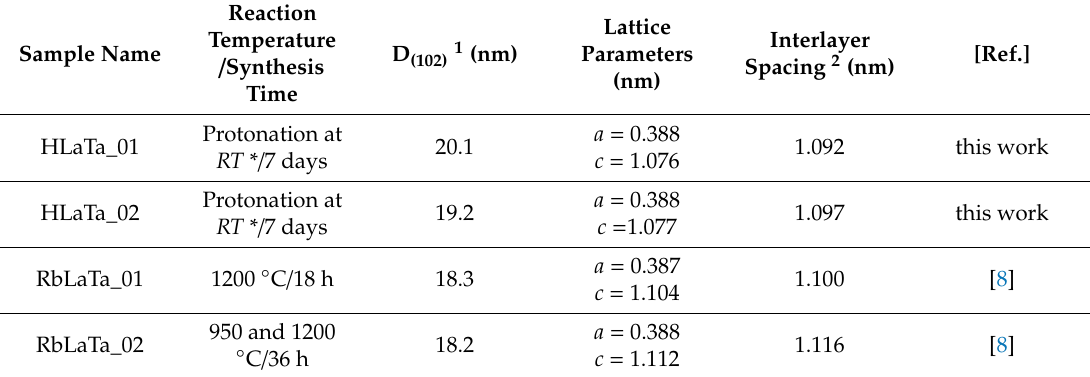
Table 1. Synthesis conditions and lattice parameters of HLaTa_01(02) protonated products. For comparison, both RbLaTa_01(02) hosts [8] are given.